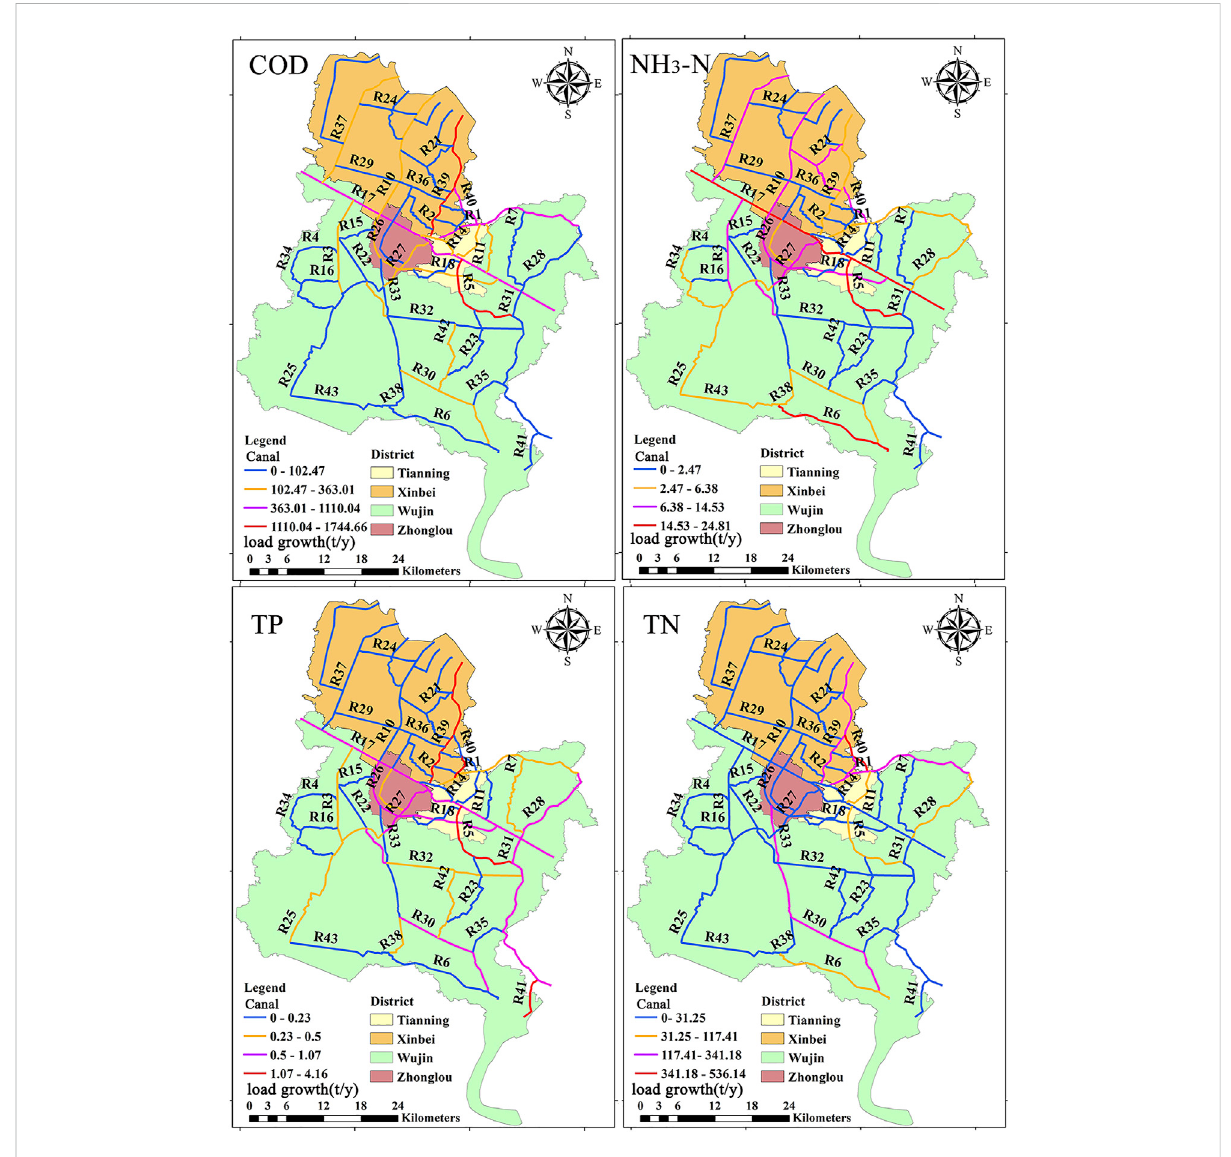
FIGURE 11 Water environmental capacity fl uctuation of different